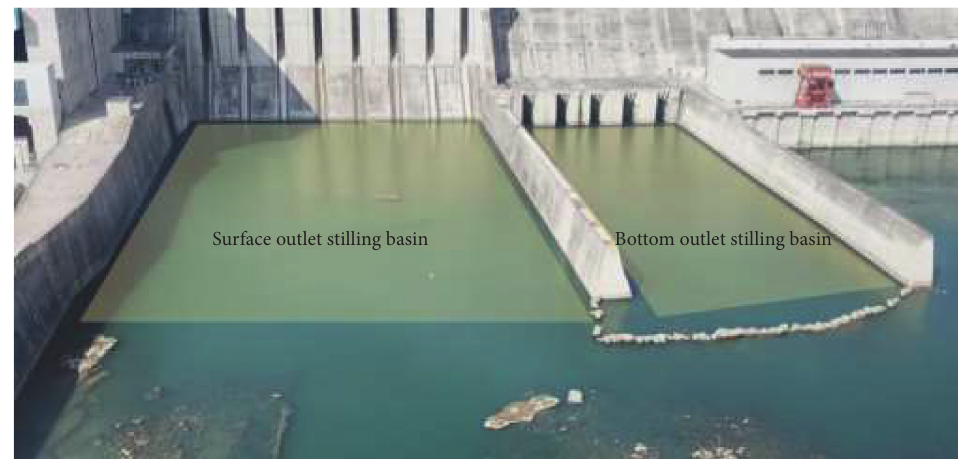
Figure 2: The picture of surface outlet stilling basin and bottom outlet stilling